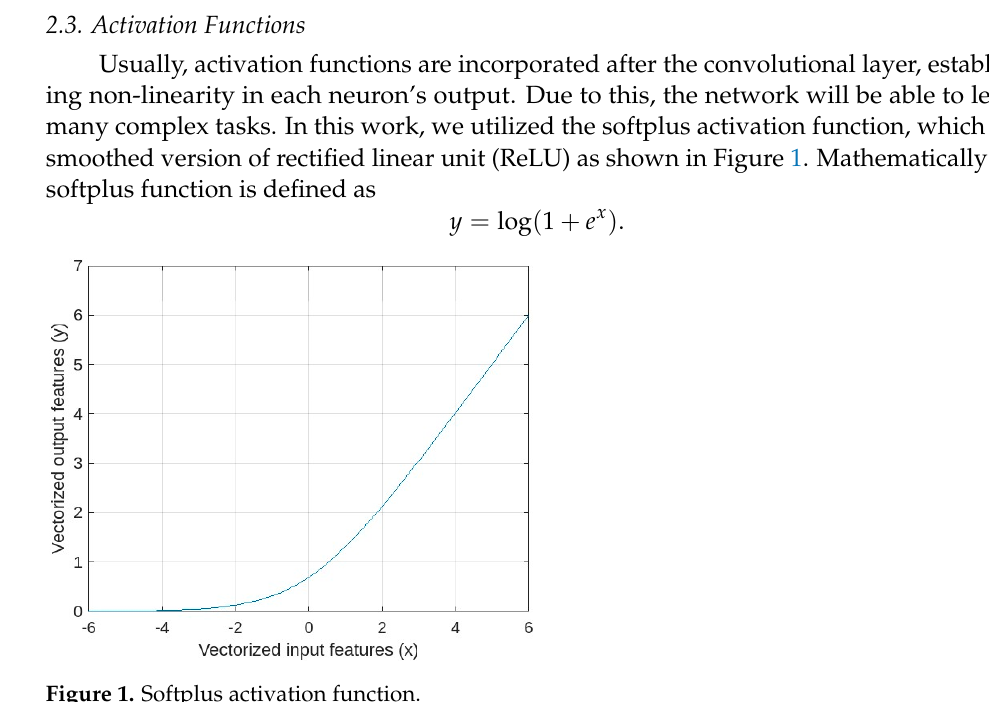
Algorithm 1 . Batch normalization